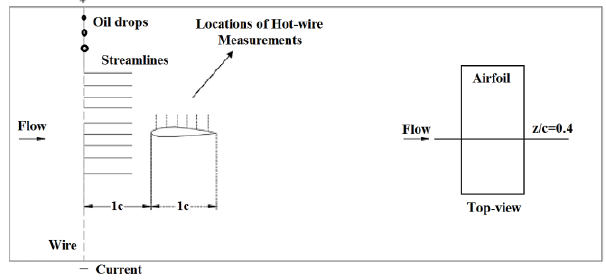
Fig. 2. A sketch of smoke-wire and hot-wire